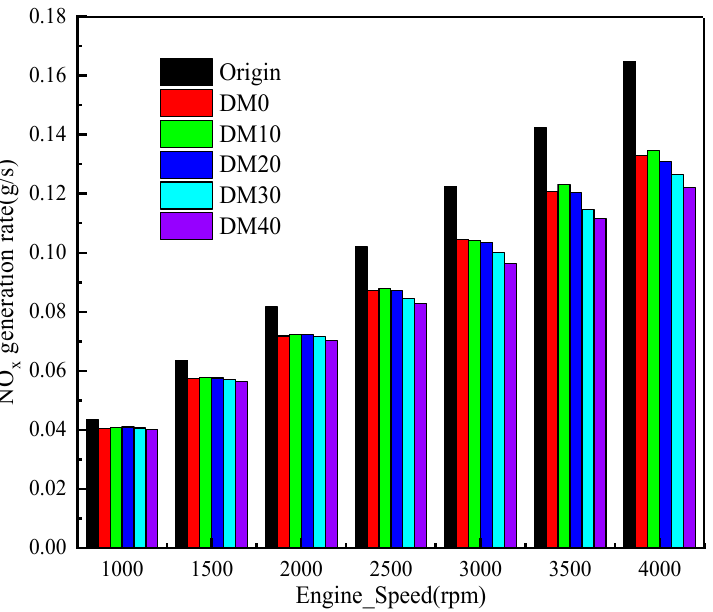
Figure 10. Effect of different ratios of methanol-diesel mixtures on NO x generation rate at different speeds.